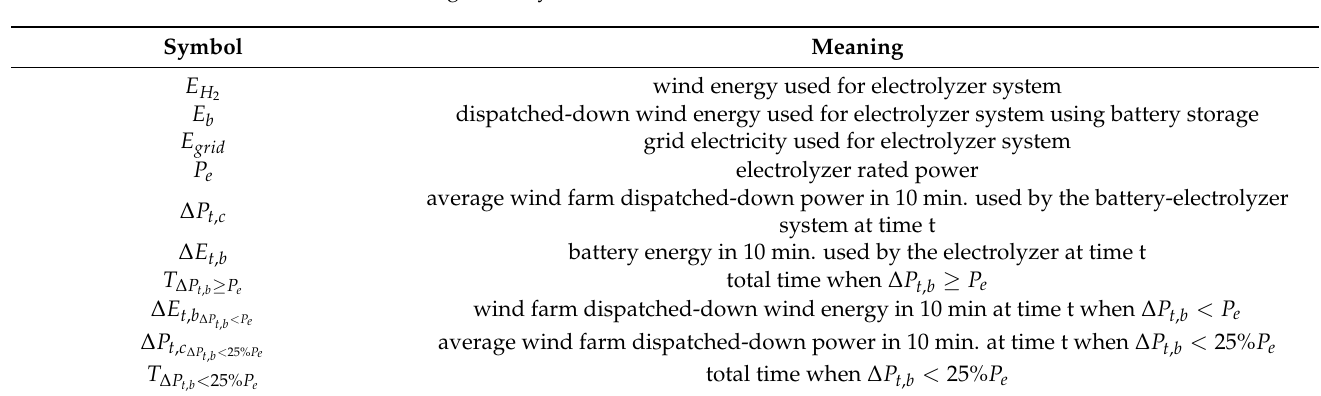
Table 5. Legend of